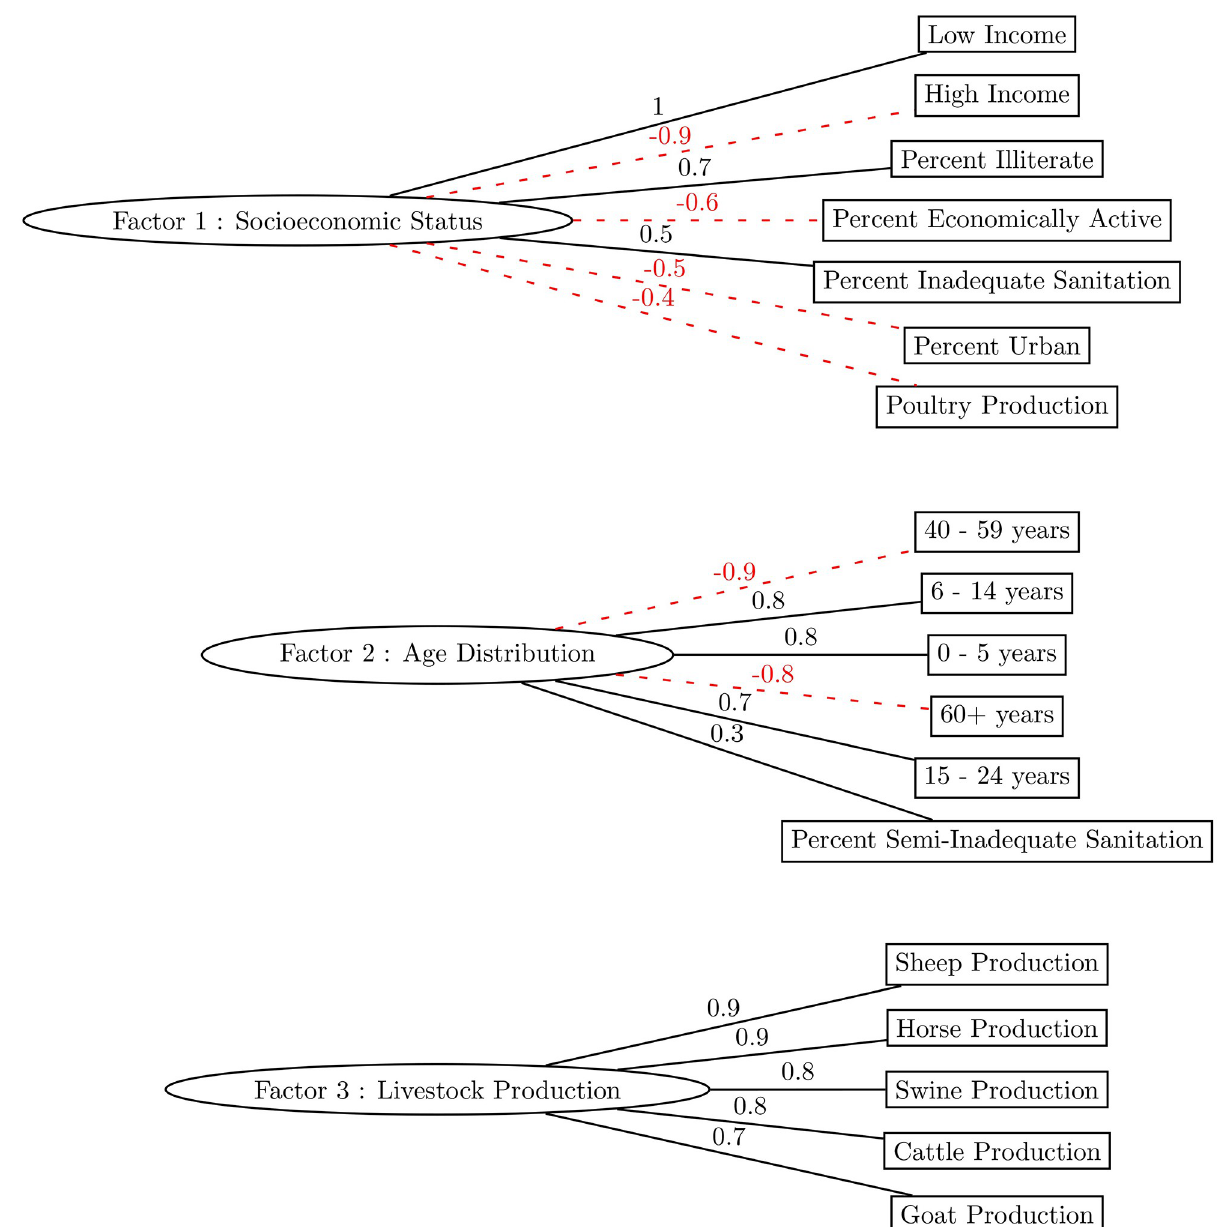
Fig 8. Human VL Exploratory Factor Analysis results with 2010 Brazilian Federal Census primary variable contributions.